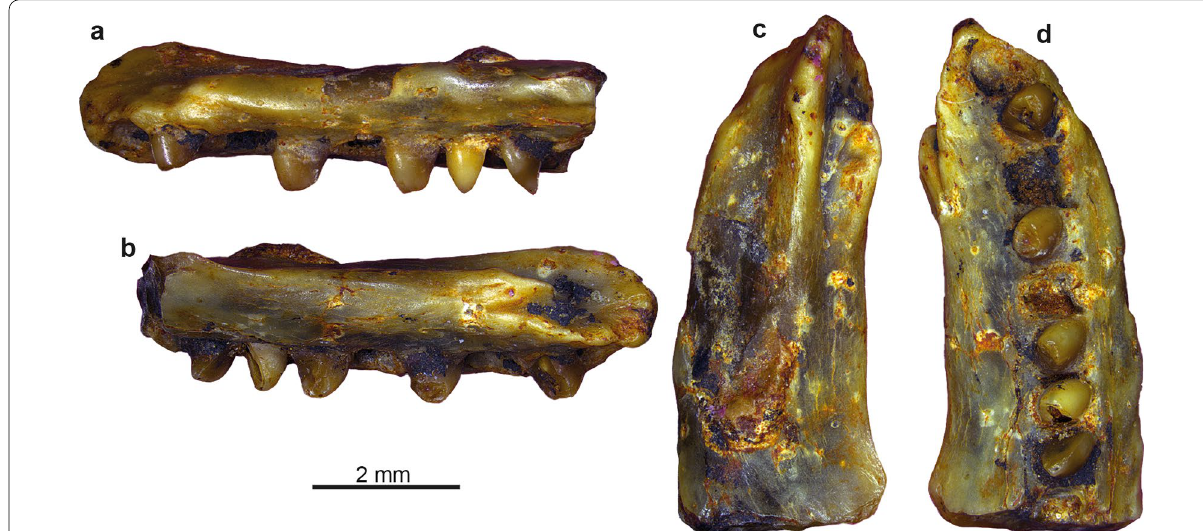
Fig. 102 Phosphoroboa filholii comb. nov. from an imprecisely known locality in the Phosphorites du Quercy: left pterygoid fragment (NHMW 2019/0020/0004) in labial ( a ), medial ( b ), dorsal ( c ), and ventral ( d )